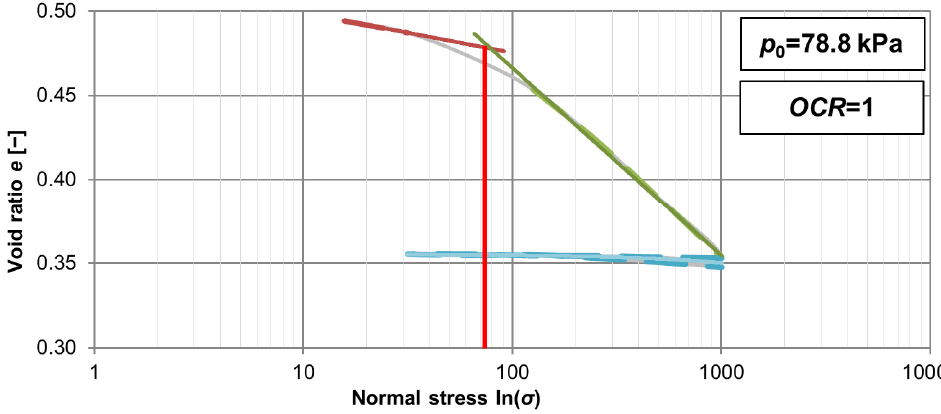
Figure 11. Preconsolidation stress determined in oedometric tests (sample No. 3).